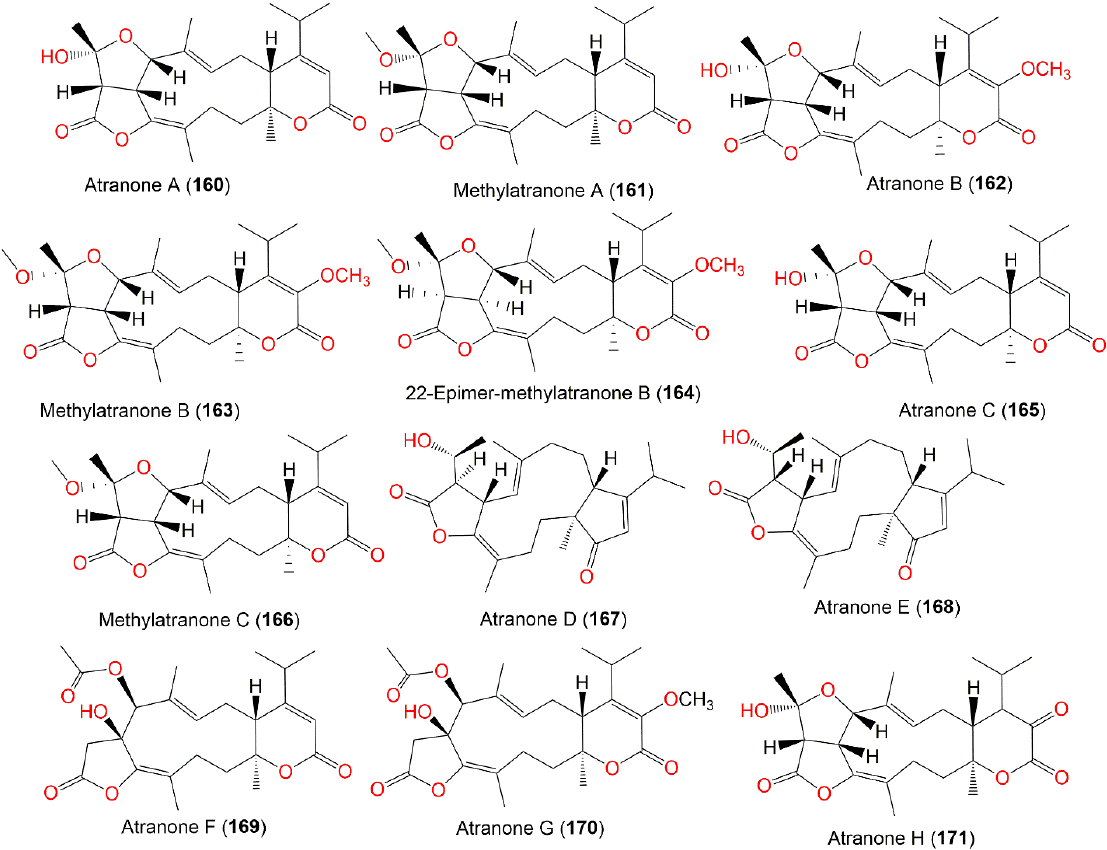
Figure 21. Structures of atranones ( 160 – 171 ) reported from S. chartarum . Their structures were established by spectral and X-ray analyses, as well as ECD (electronic circular dichroism) calculations and optical rotation. DRG (Dorsal root ganglia) neuron is commonly utilized for assessing the growth capacity of neurons and drugs’ therapeutic potential in peripheral nerve regeneration [108]. For successful peripheral nerve regeneration, the first step is the axonal regrowth from injured neurons. The axonal regeneration potential of 162 was estimated using primary DRG neurons. Compound 162 boosted neurite outgrowth from adult dorsal root ganglia neurons remarkably without influencing cell survival (conc. 1 μ g/mL) Besides, 161 – 164 , 175 , 176 , 178 , and 179 (Figure 22) had no cytotoxic potential versus MDA-MB-435 in the MTT [108].